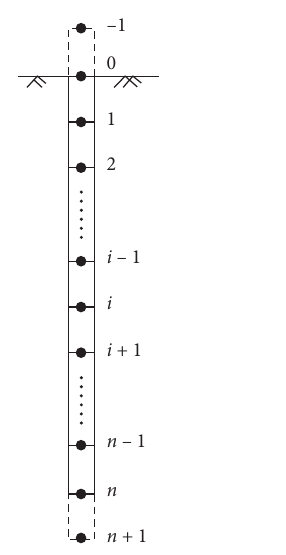
Figure 3: Schematic diagram of the differential dispersion of pure torsion